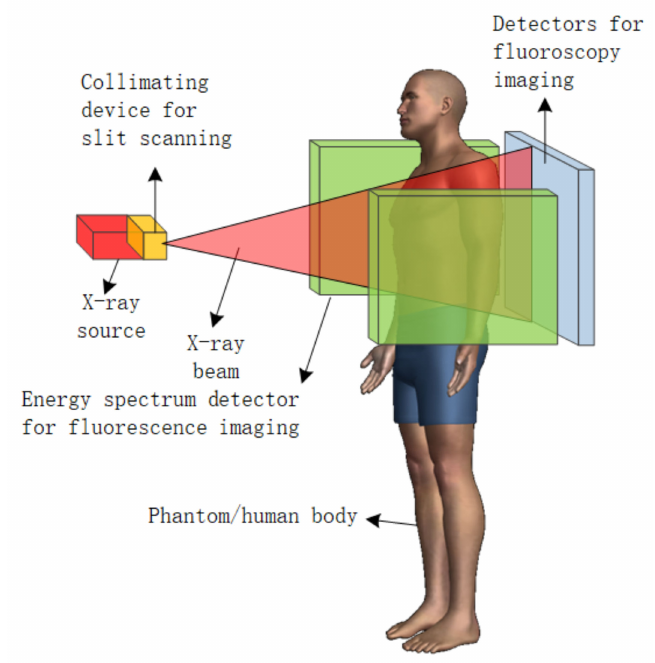
Figure 3. Schematic diagram of slit scanning